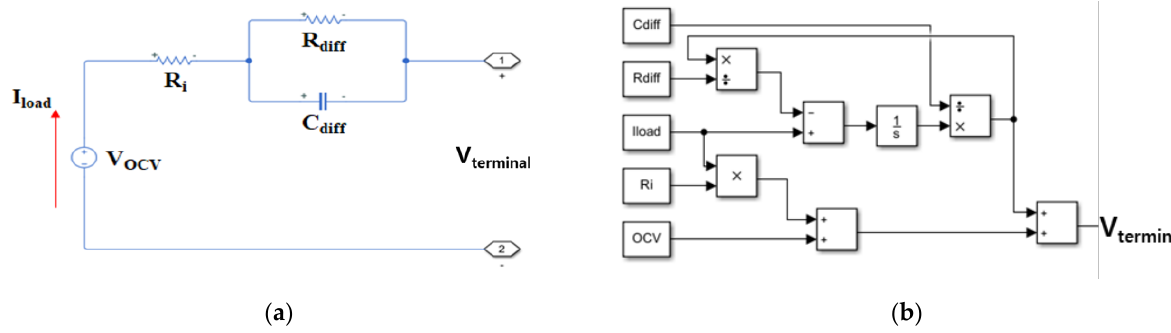
Figure 3. Modeling the battery ECM by MATLAB/Simulink: ( a ) modeling using the simscape library; ( b ) equation-based modeling using basic blocks.